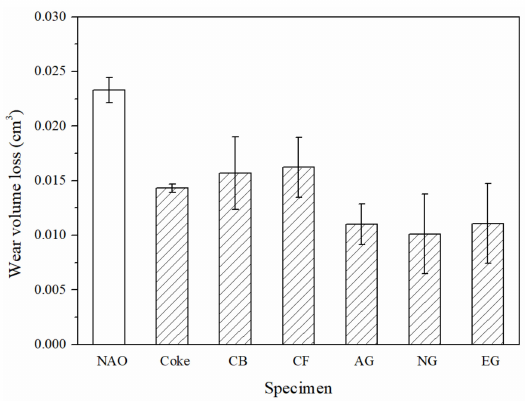
Figure 7. The wear loss of